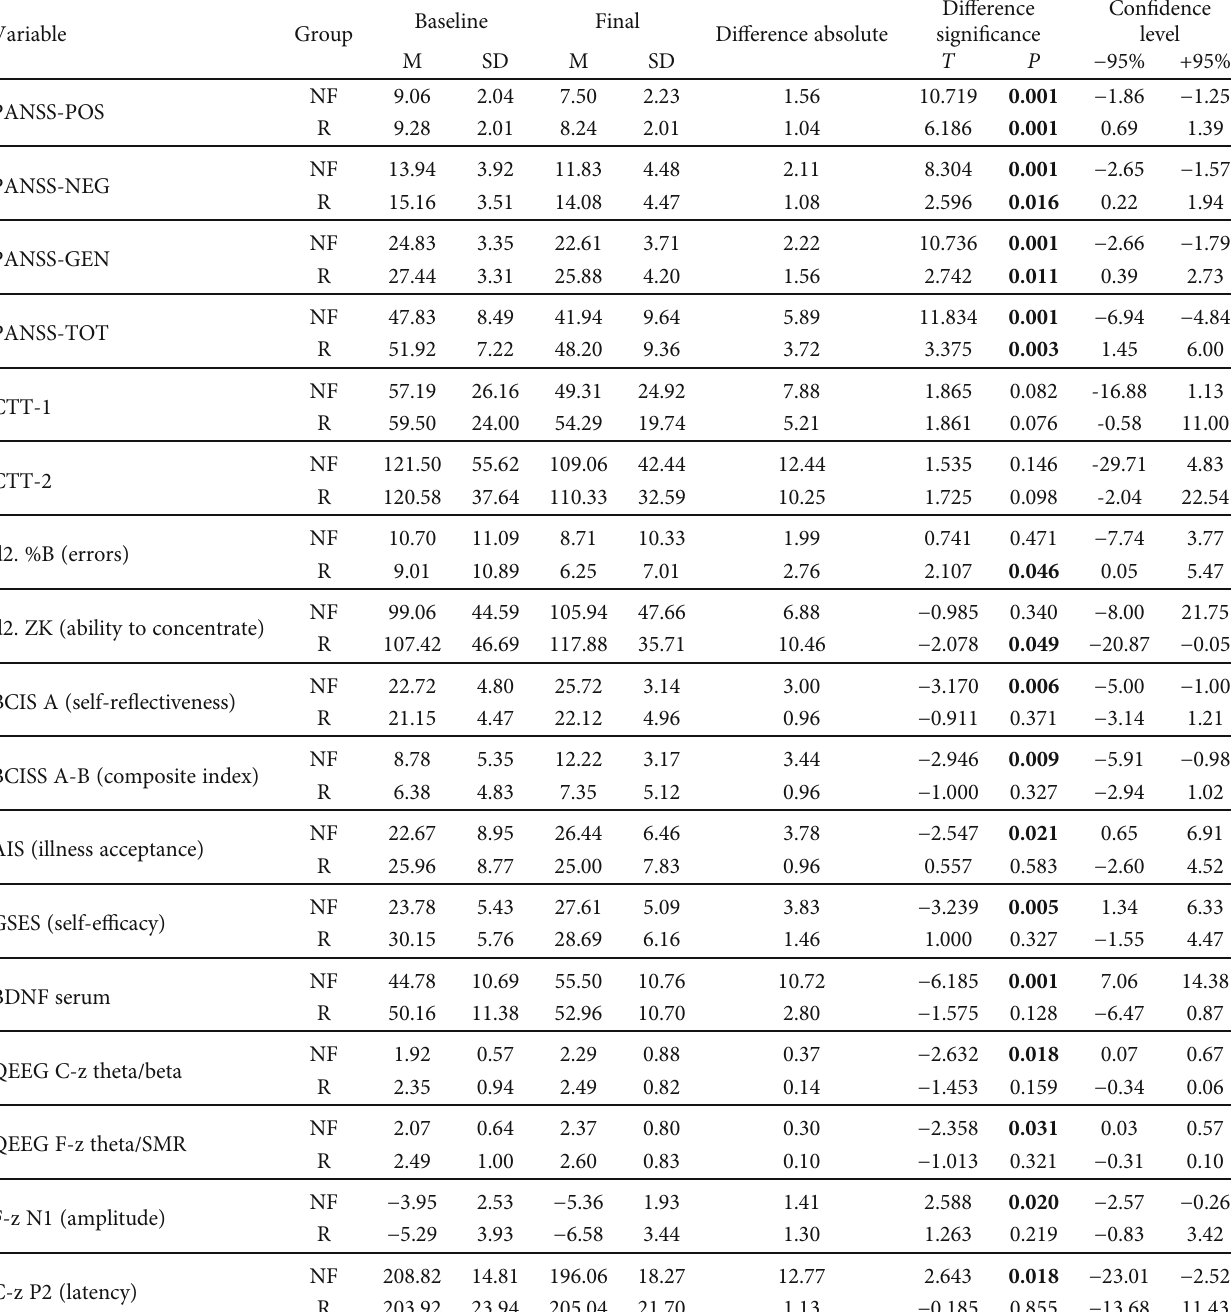
Table 1: Baseline and fi nal results of combined NF/standard rehabilitation versus standard